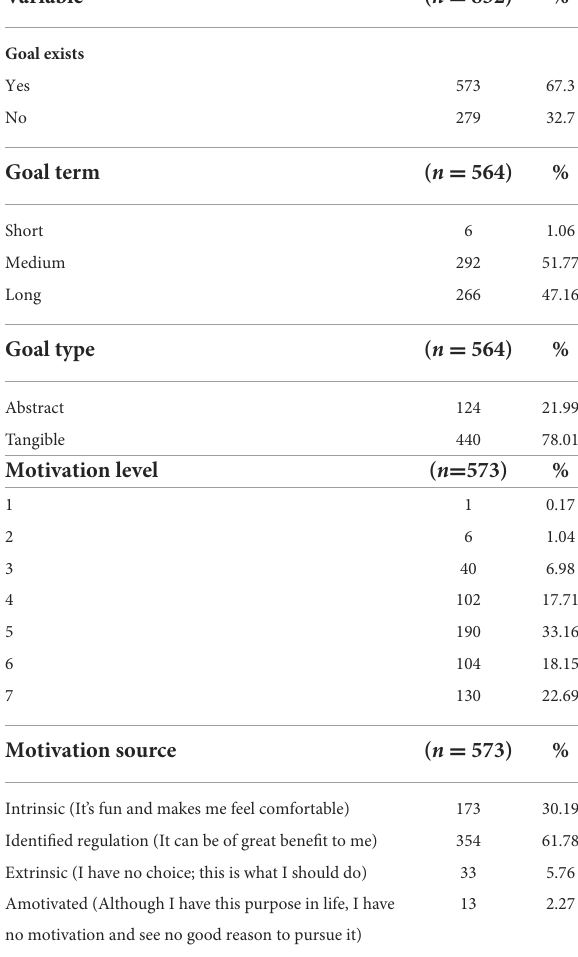
TABLE 1 Goal existence, type, and